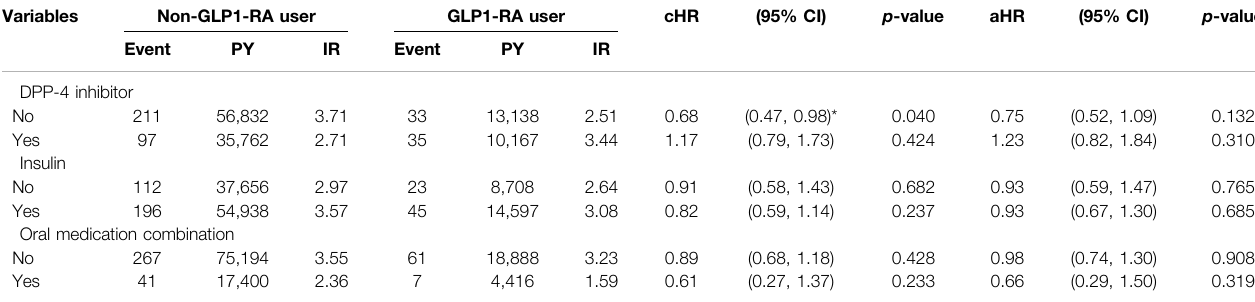
TABLE 4 | ( Continued ) Factors associated with depression incidence in diabetes patients with/without GLP1-RA: subgroup analysis. Variables